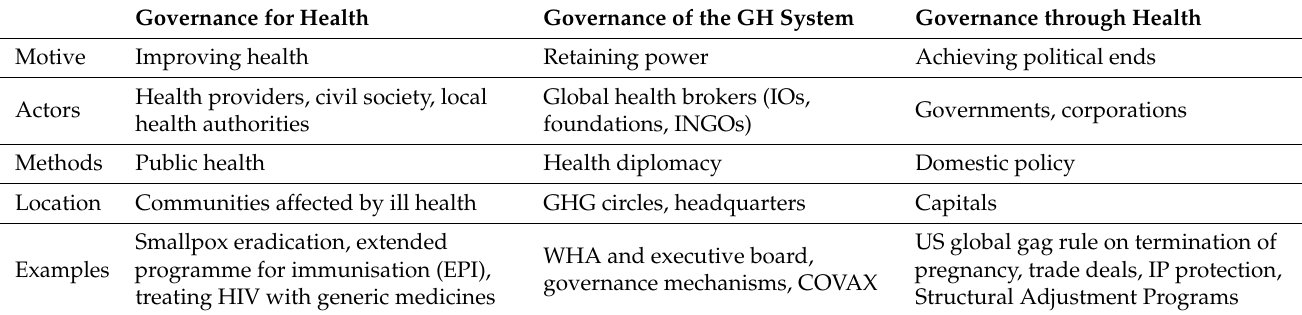
Table 1. Drivers of Global Health